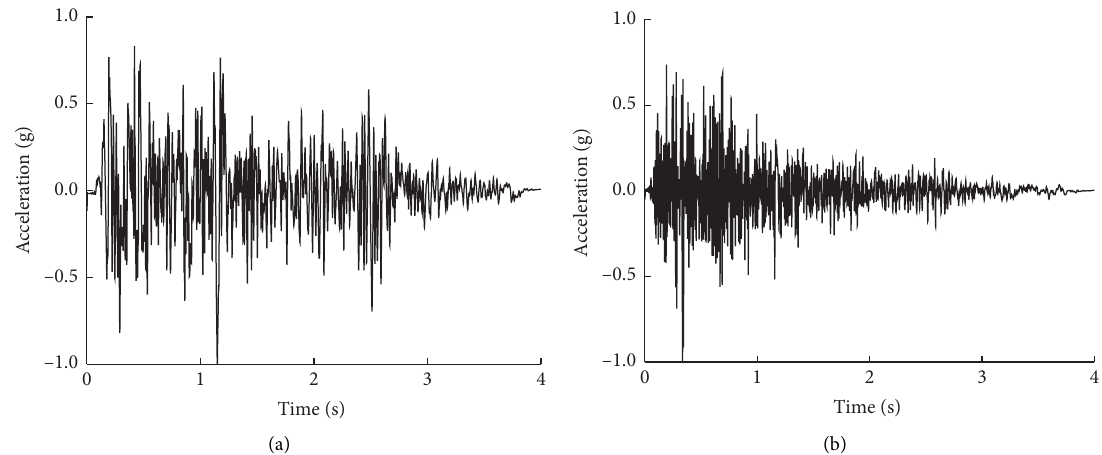
Figure 6: The input El Centro earthquake motions. (a) The horizontal seismic excitation. (b) The vertical seismic